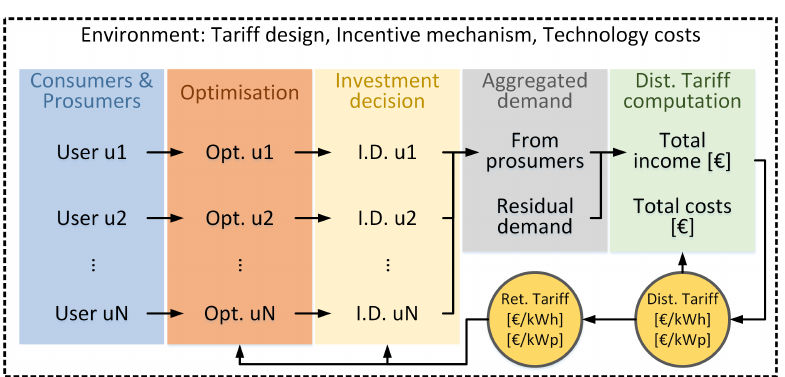
Figure 2. Flow diagram of the proposed multi-agent simulator. The flow of actions occurs from left to right. The distribution network consumers undergo individual MILP optimisations to minimise their LCOEs. A transition consumer → prosumer is computed (investment decision tab (yellow) on the Figure), and finally the DSO adjusts the distribution